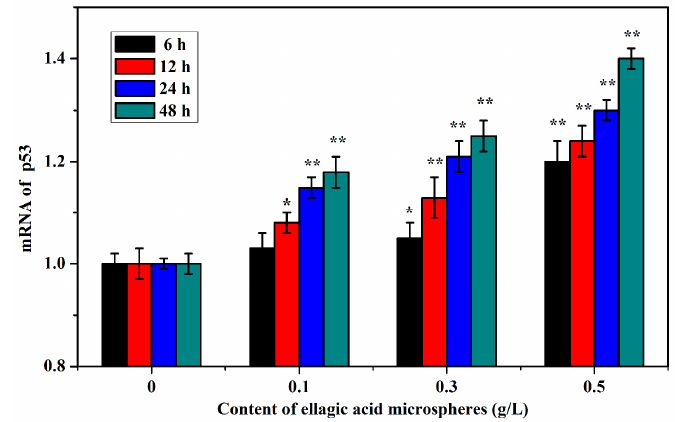
Figure 7. Effects of different concentrations of ellagic acid microspheres on the expression of p53 in HepG2 cells. Significant differences between the ellagic acid microsphere groups and control group were tested using the S–N–K test, * p < 0.05 and ** p < 0.01.